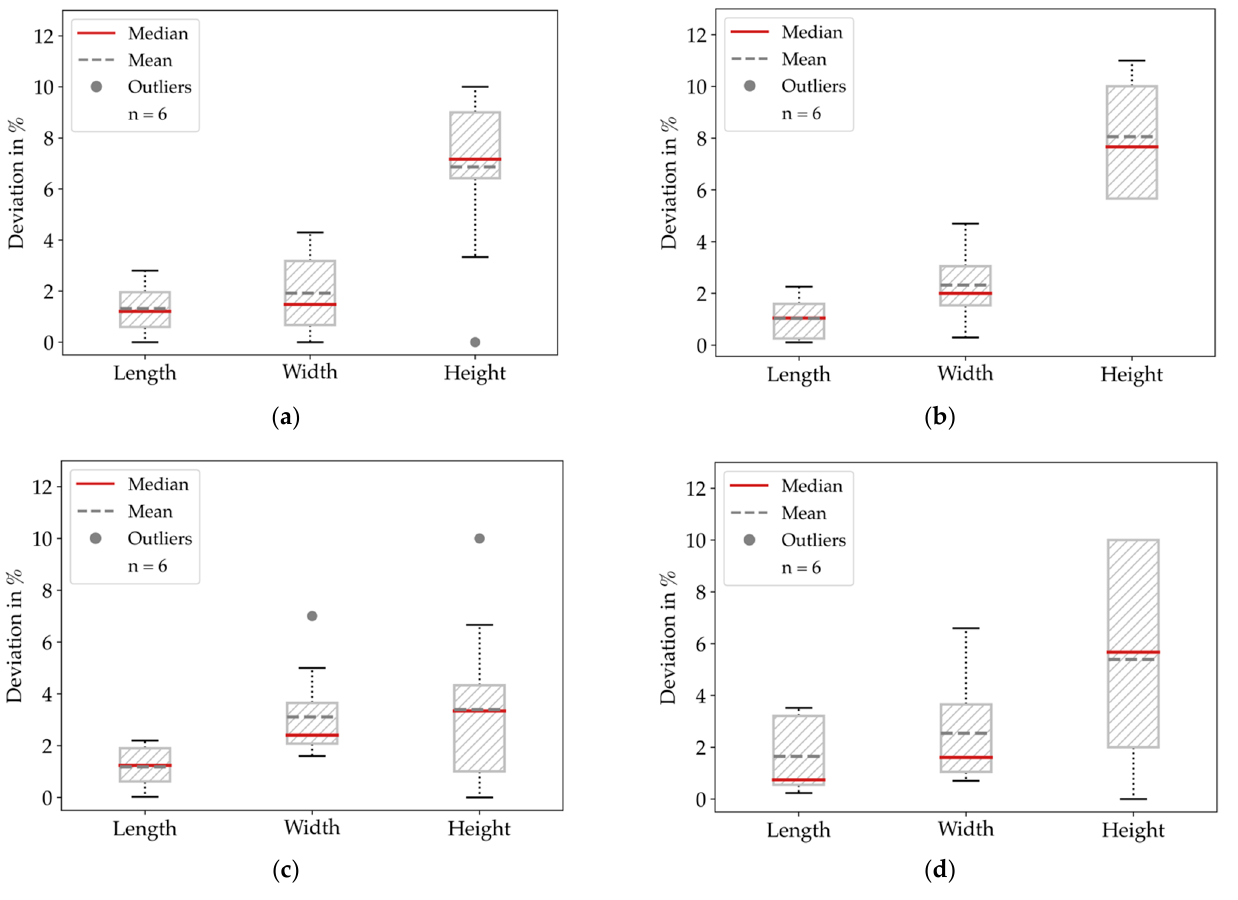
Figure 9. Global deviations between the CAD dimensions and the measured specimens: ( a ) ID 25; ( b ) ID 50; ( c ) ID 75; ( d ) ID 100. The smallest deviations are observed for ID 75. Table 3. Mean values for the deviations between the final part and CAD model. Length and width represent the printing plane and height of the stacking direction. The deviations adjusted for the scaling factor bias are given in brackets.